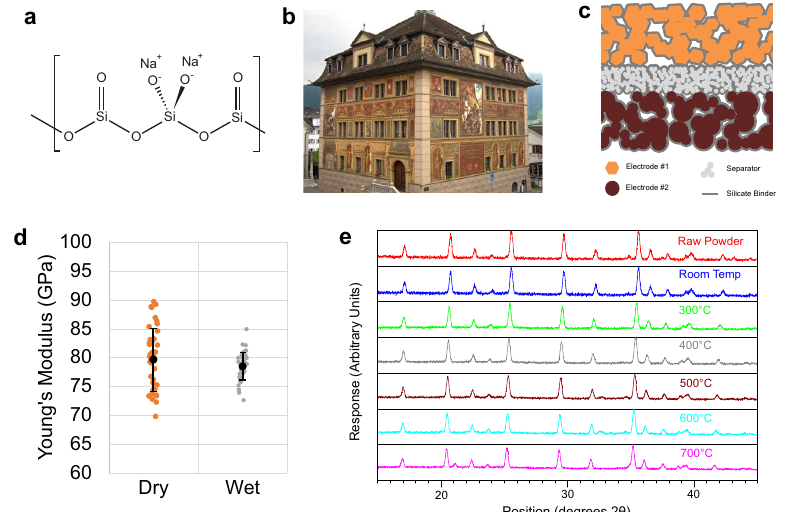
Fig. 1 Use of silicate waterglass as a versatile adhesive. a The structure of sodium silicate waterglass. b Silicate-based mineral paint is chemically stable and able to withstand decades of exposure. c Structural ceramic battery (SCB) lay-up, using waterglass as a rigid binder within and between cell stack layers. d Silicate does not soften in the presence of EC:DMC electrolyte solvent (error bars: standard deviation). e In situ X-ray diffractogram demonstrates that silicate is stable when heated with Lithium Iron Phosphate up to 600